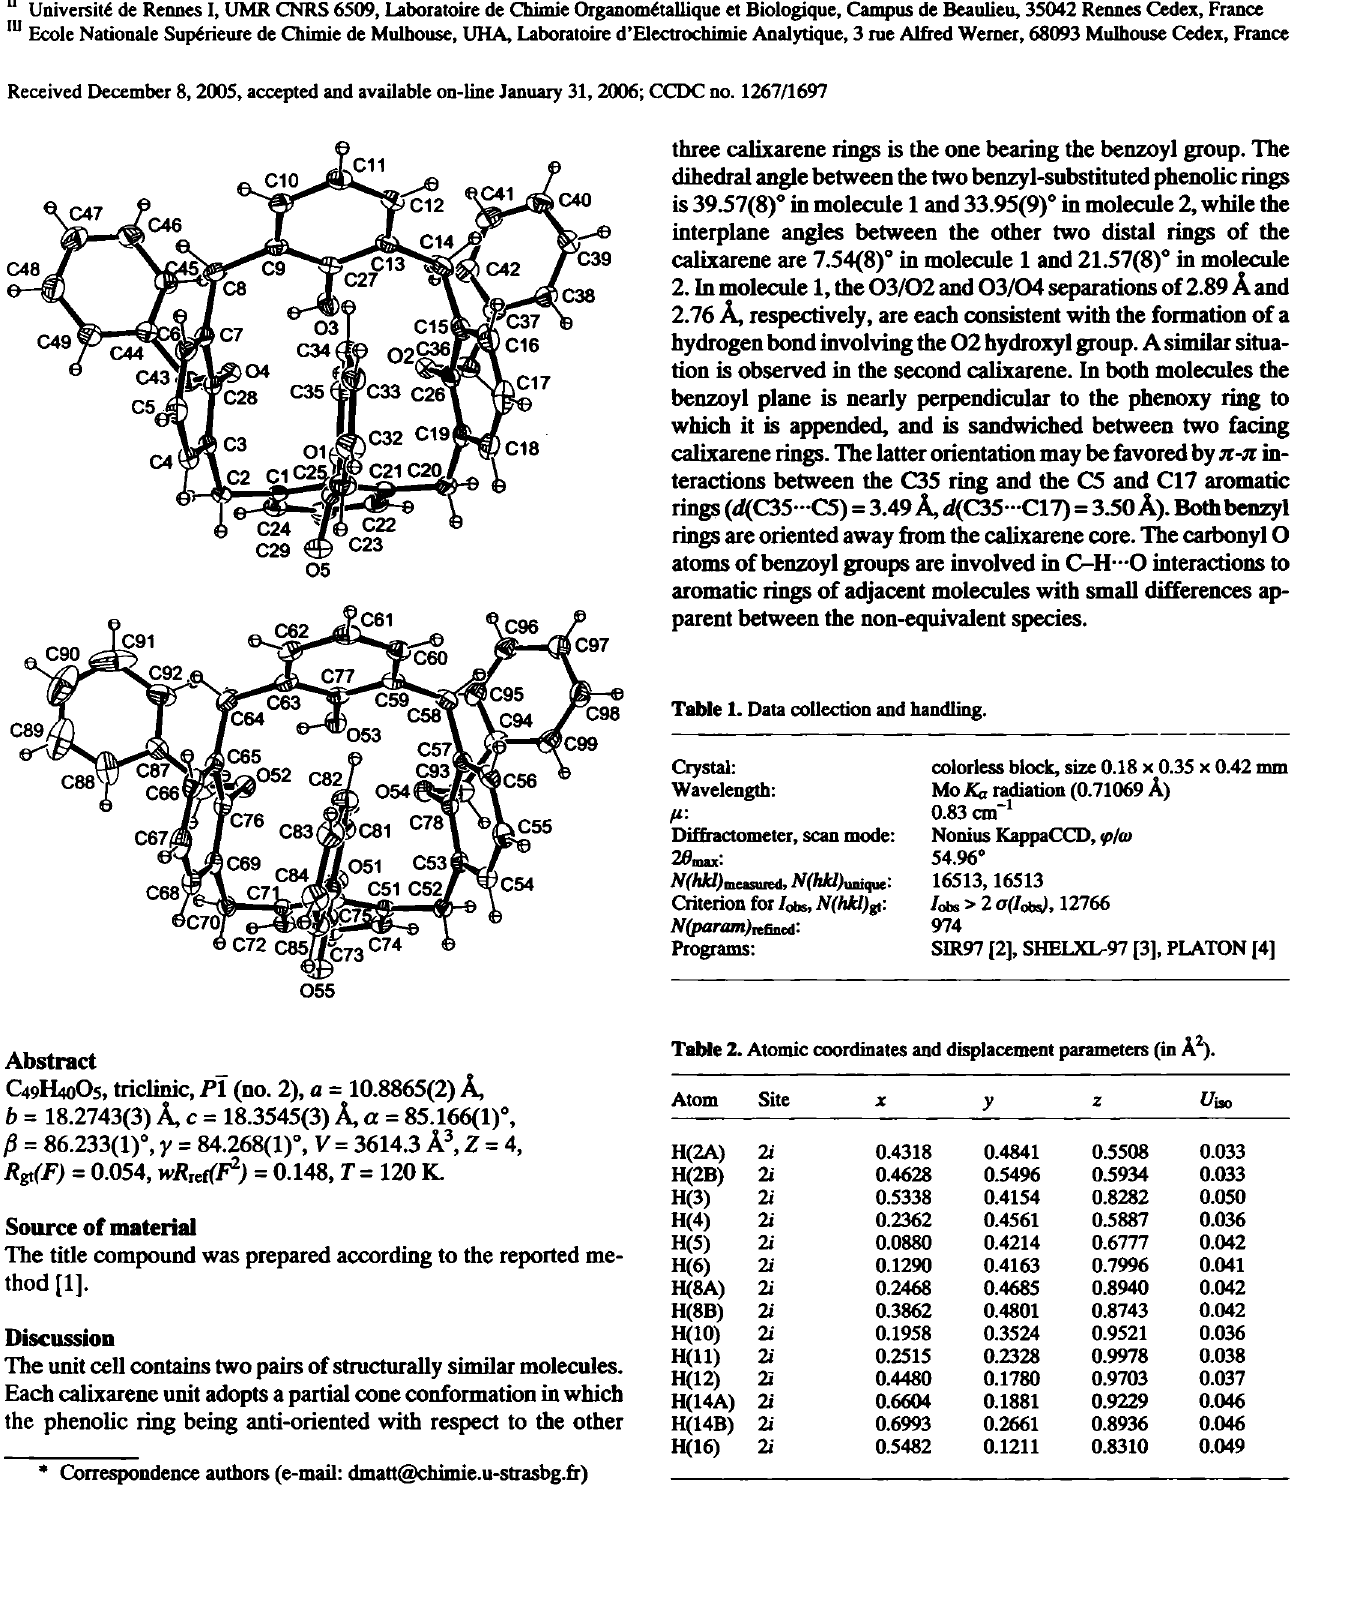
Table 2. Atomic coordinates and displacement parameters (in A 2